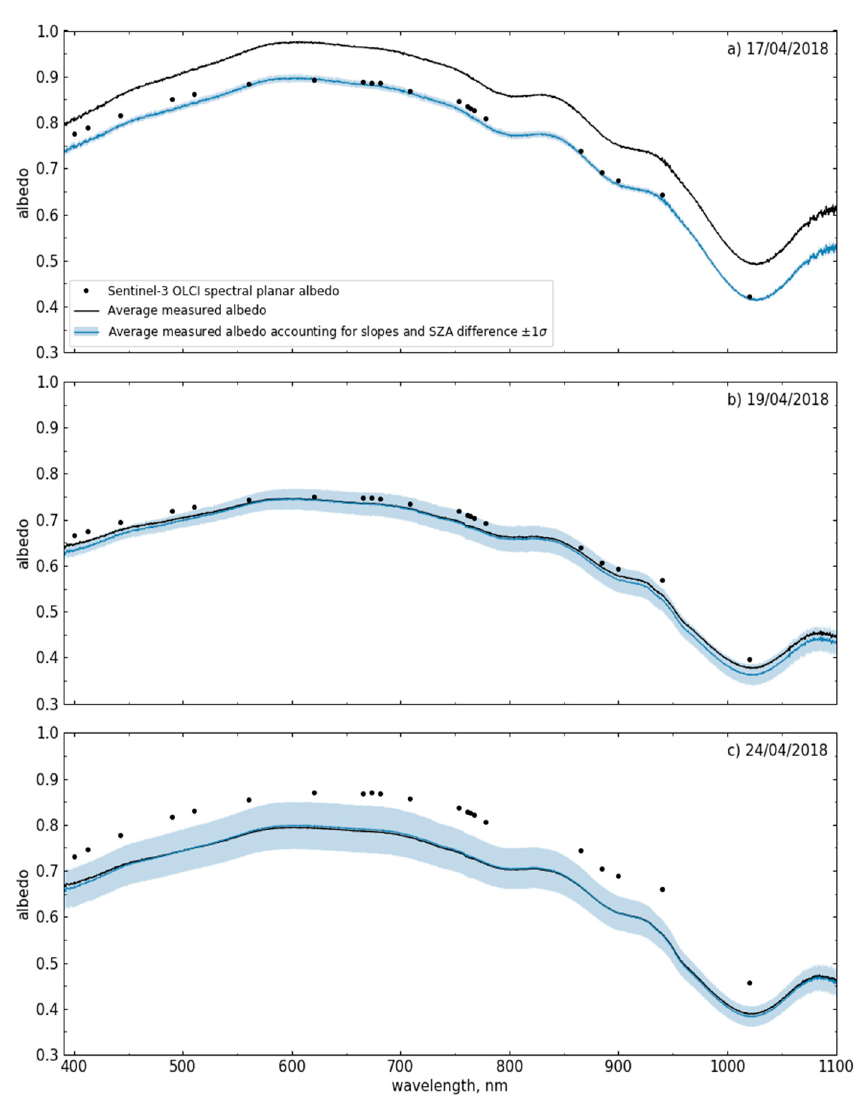
Figure 13. Comparison of the retrieved Sentinel-3 OLCI spectral planar albedo for polluted snow (black markers) and the measured albedo (black lines) at Col du Lautaret for three dates in April 2018, after a dust deposition event. The planar albedo accounting for the slope under the sensor calculated for the SZA at the time of the satellite overpass based on the measurements is shown in blue. The blue shaded area represents the sub-pixel variability.